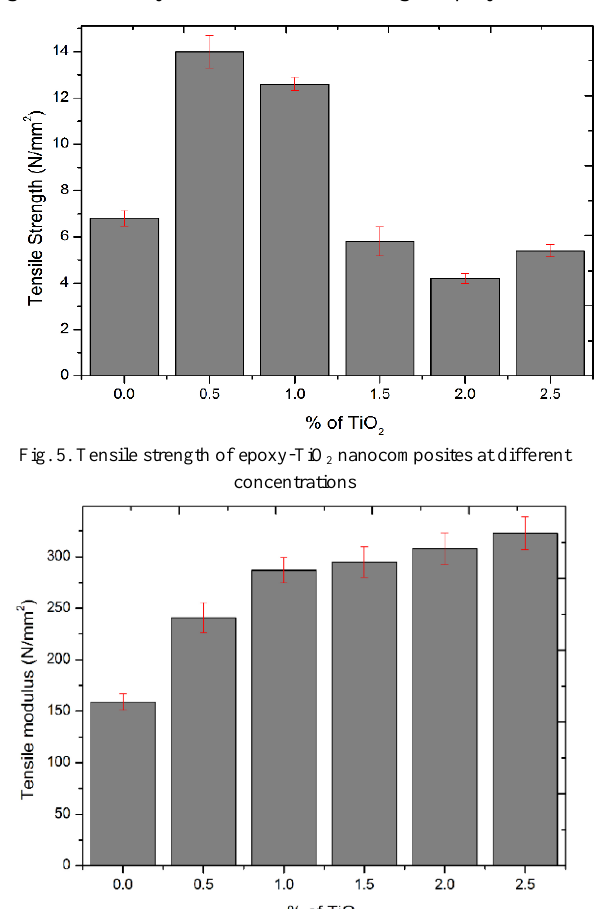
Table 2. Tensile properties of nanocomposites synthesized %